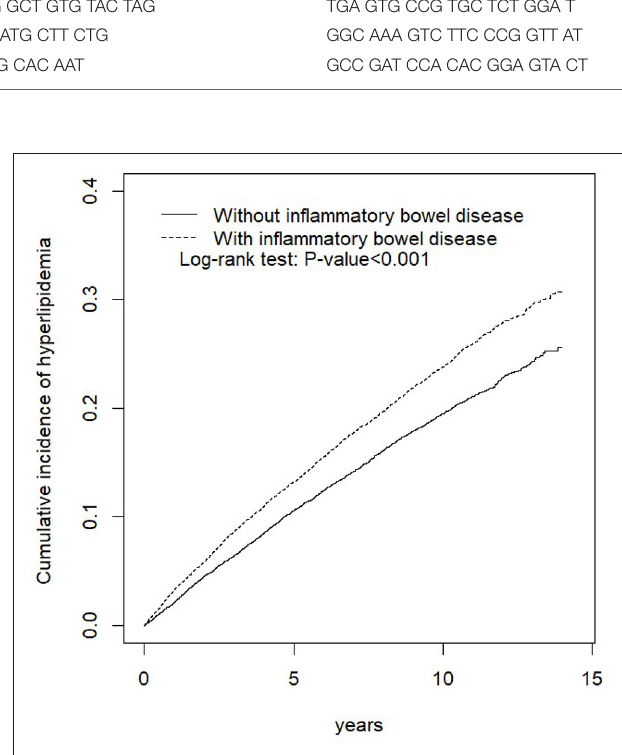
FIGURE 1 | Cumulative incidence of hyperlipidemia compared between the cohort with and without inflammatory bowel disease (IBD) using the Kaplan–Meier